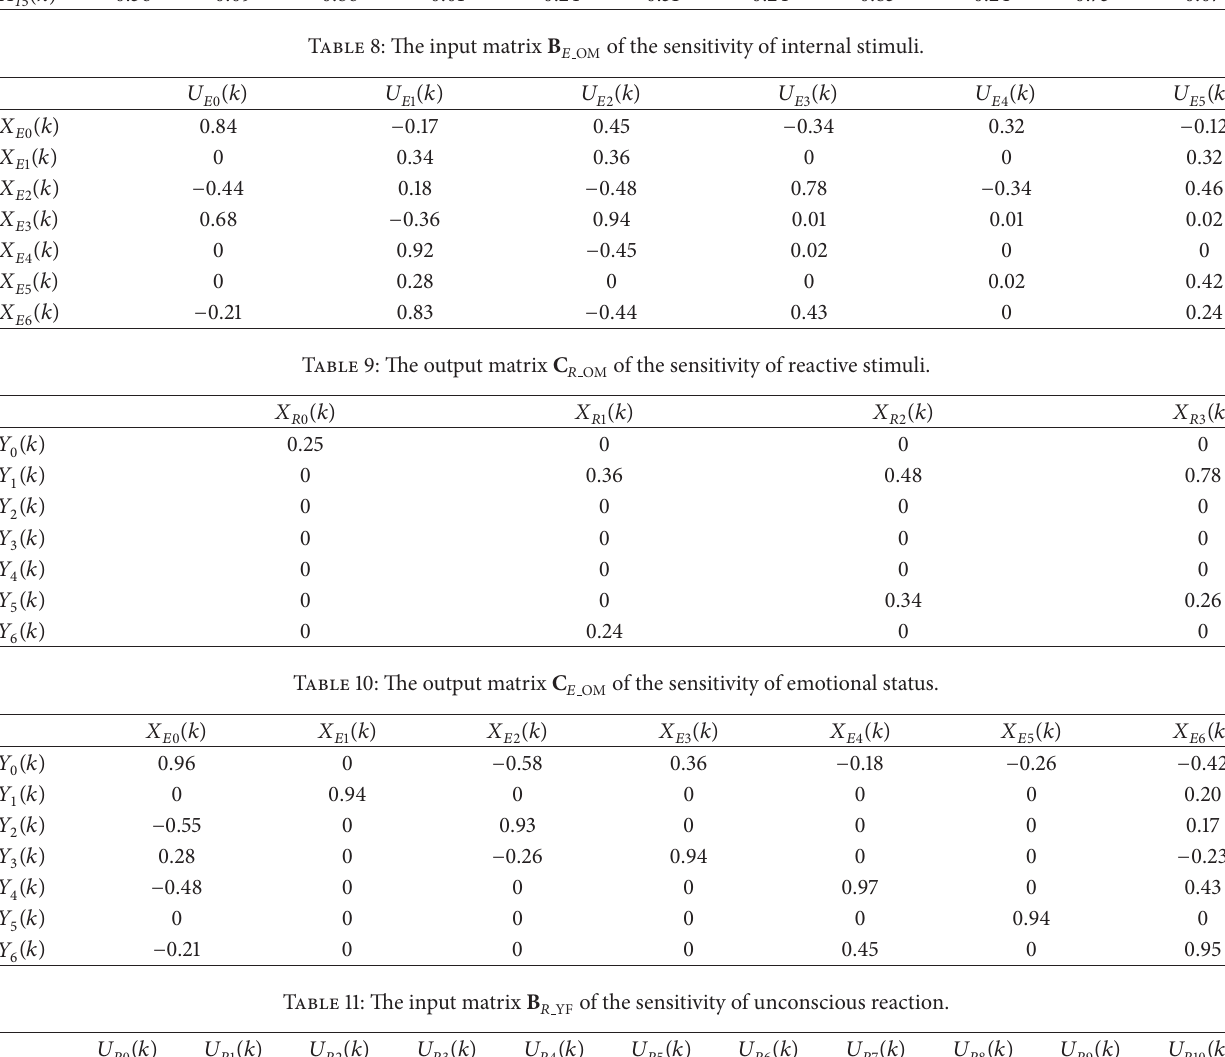
Table 8: The input matrix B 𝐸